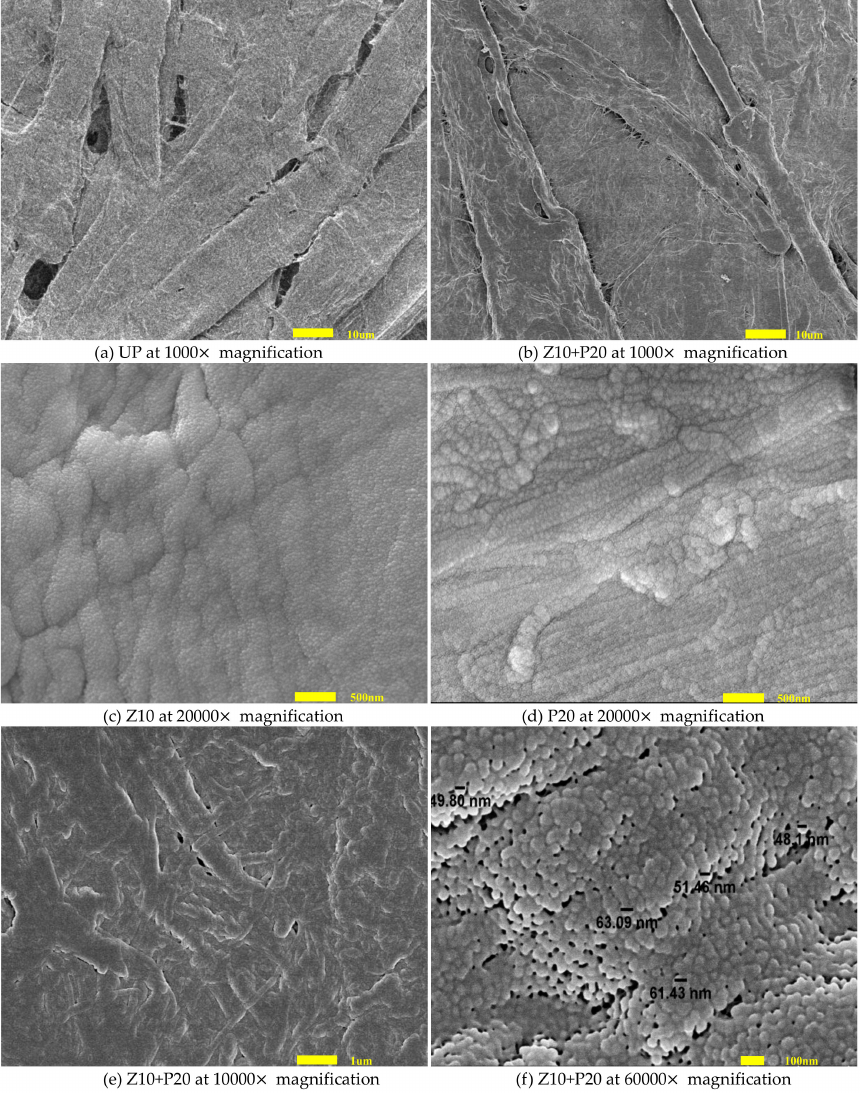
Figure 8. SEM images of ( a ) UP, ( b ) Z10 + P20, ( c ) Z10, ( d ) Z10 + P20, ( e ) Z10 + P20, and ( f ) Z10 +